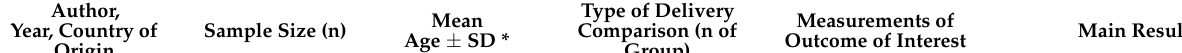
Table 1. Basic characteristics of the included studies of this systematic